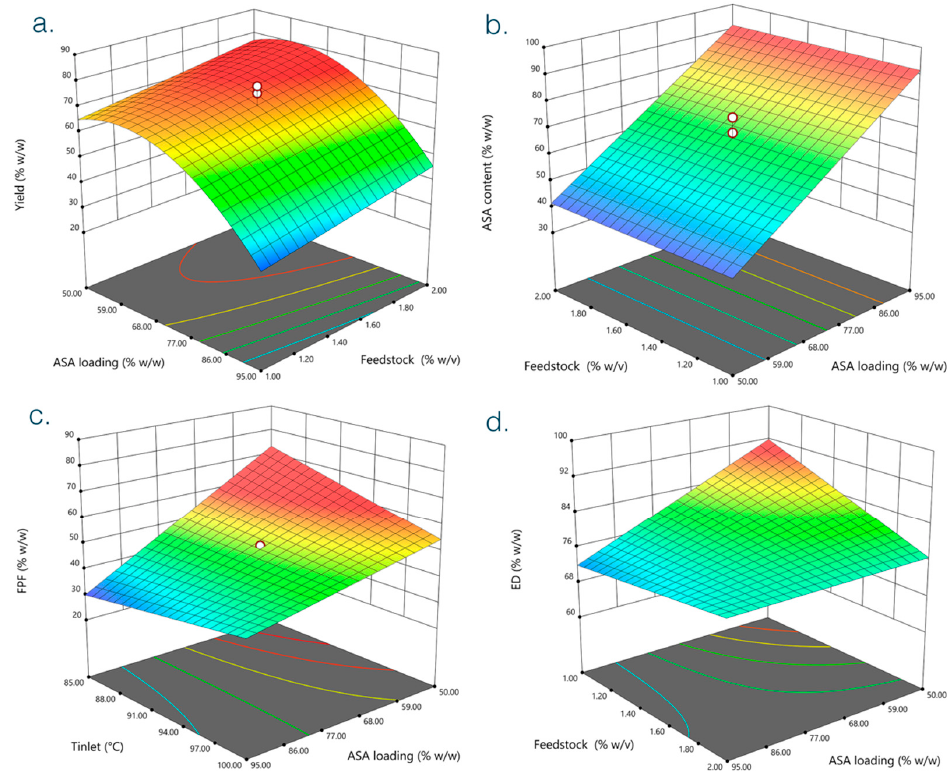
Figure 1. Surface plots of the four responses in Table 2: ( a ) Yield, ( b ) ASA content, ( c ) FPF, and ( d ) ED. Graphs were built against significant factors according to the results of ANOVA validation of the models obtained (see Table S1). Color map: red-shaded = high, green-shaded = medium, and blue-shaded = low response values.